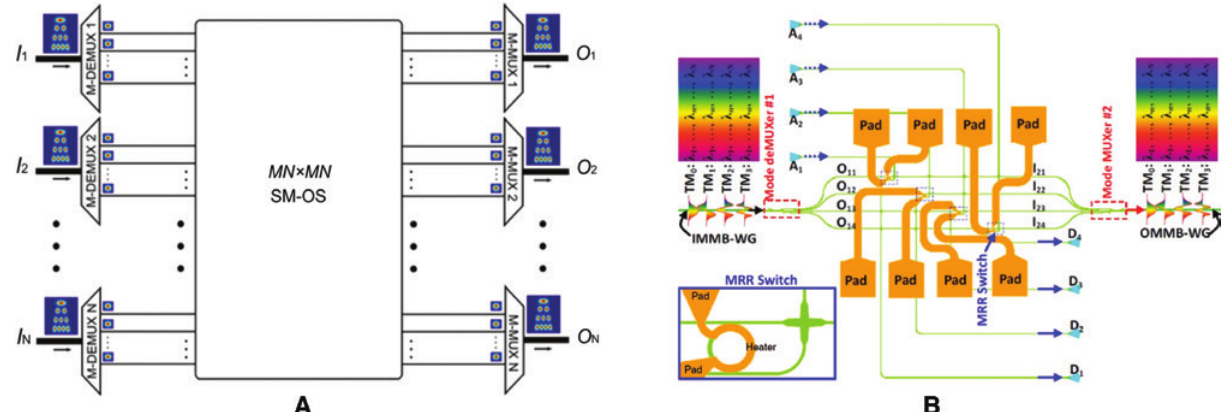
Figure 12: On-chip reconfigurable silicon photonic